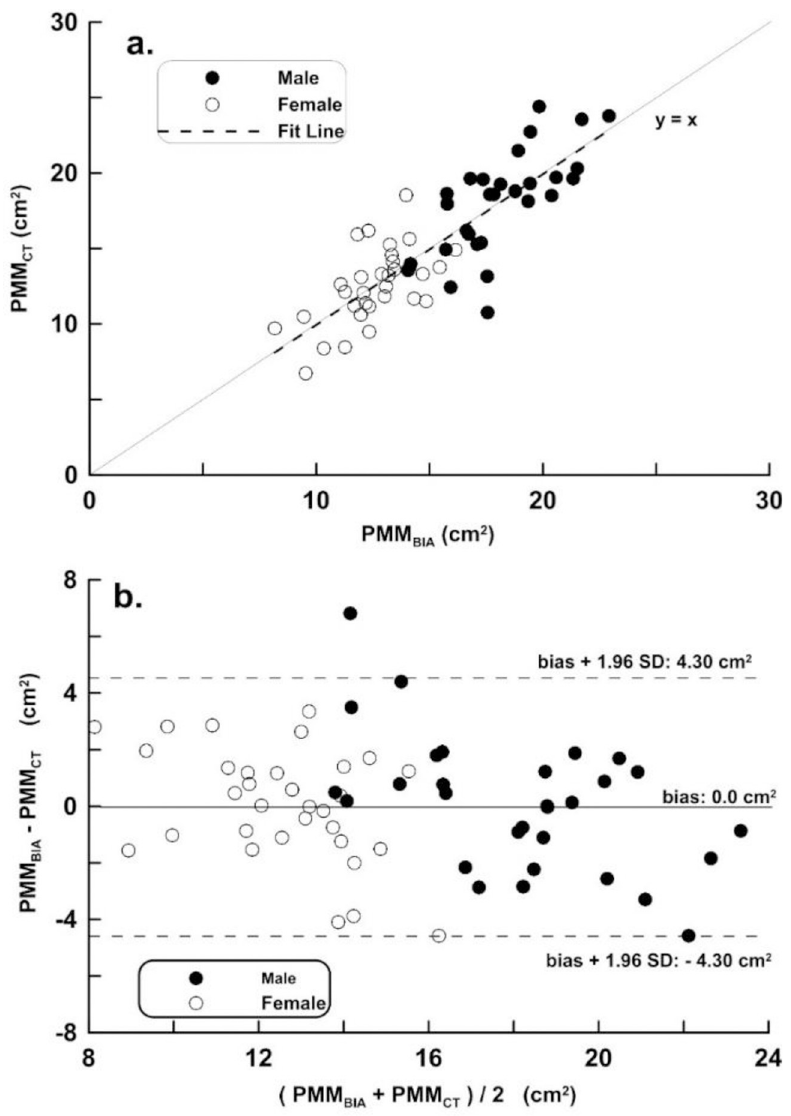
Fig 3. Scatter and Bland-Altman diagram of modeling group. Correlation analysis (top) and difference analysis (bottom) between psoas major muscle (PMM) by computed tomography (PMM CT ) and bioimpedance analysis (BIA) in the modeling group (MG). The difference (PMM CT − PMM BIA of Bland-Altman) is the mean of the corresponding measurements of PMM to CT and BIA. Black filled circles represent males and black open circles represent females.